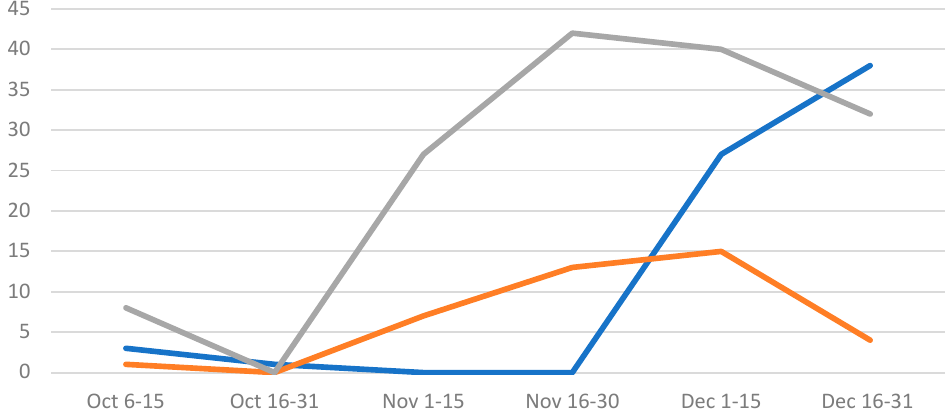
50 kW Charging station Figure 6. The evolution of the charging sessions number at the three stations, between October 2018